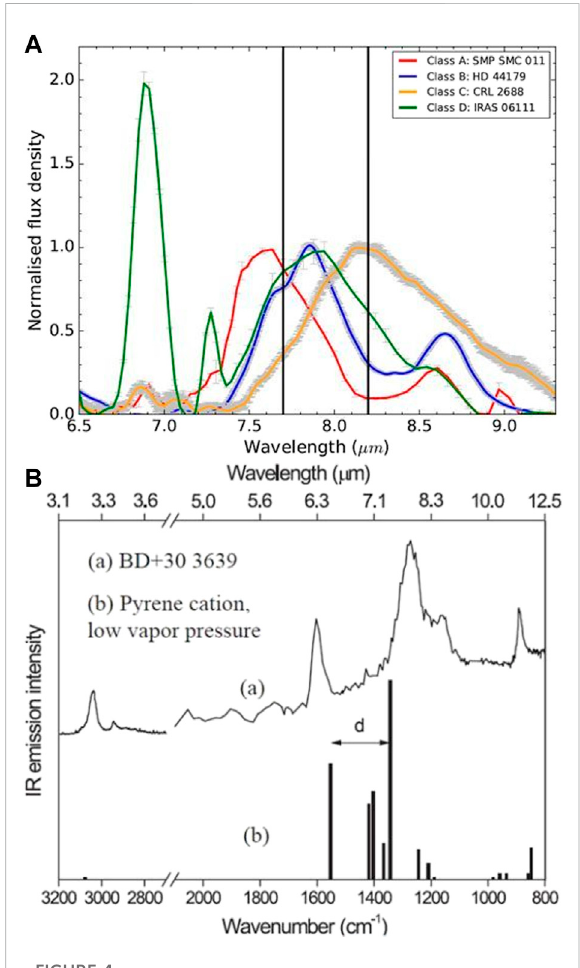
FIGURE 4 (A) : example of spectra for each of the pro fi le classes of the aromatic infrared bands (AIBs) in (W m − 2 μ m − 1 ), normalized to the integrated fl ux of the 7.7 μ m feature (Jensen et al., Astron. Astrophys. 665, A153, 2022, reproduced with permission © ESO). (B) : infrared emission spectrum of the pyrene cation (C 16 H 10 + ),shownas sticksinthelowerpart, compared withtheAIB spectrum of the planetary nebula BD +30_3639. From Kim and Saykally, 2002, Astrophys. J. Suppl. Ser. 143, 455 doi:10.1086/ 343078. © AAS, reproduced with